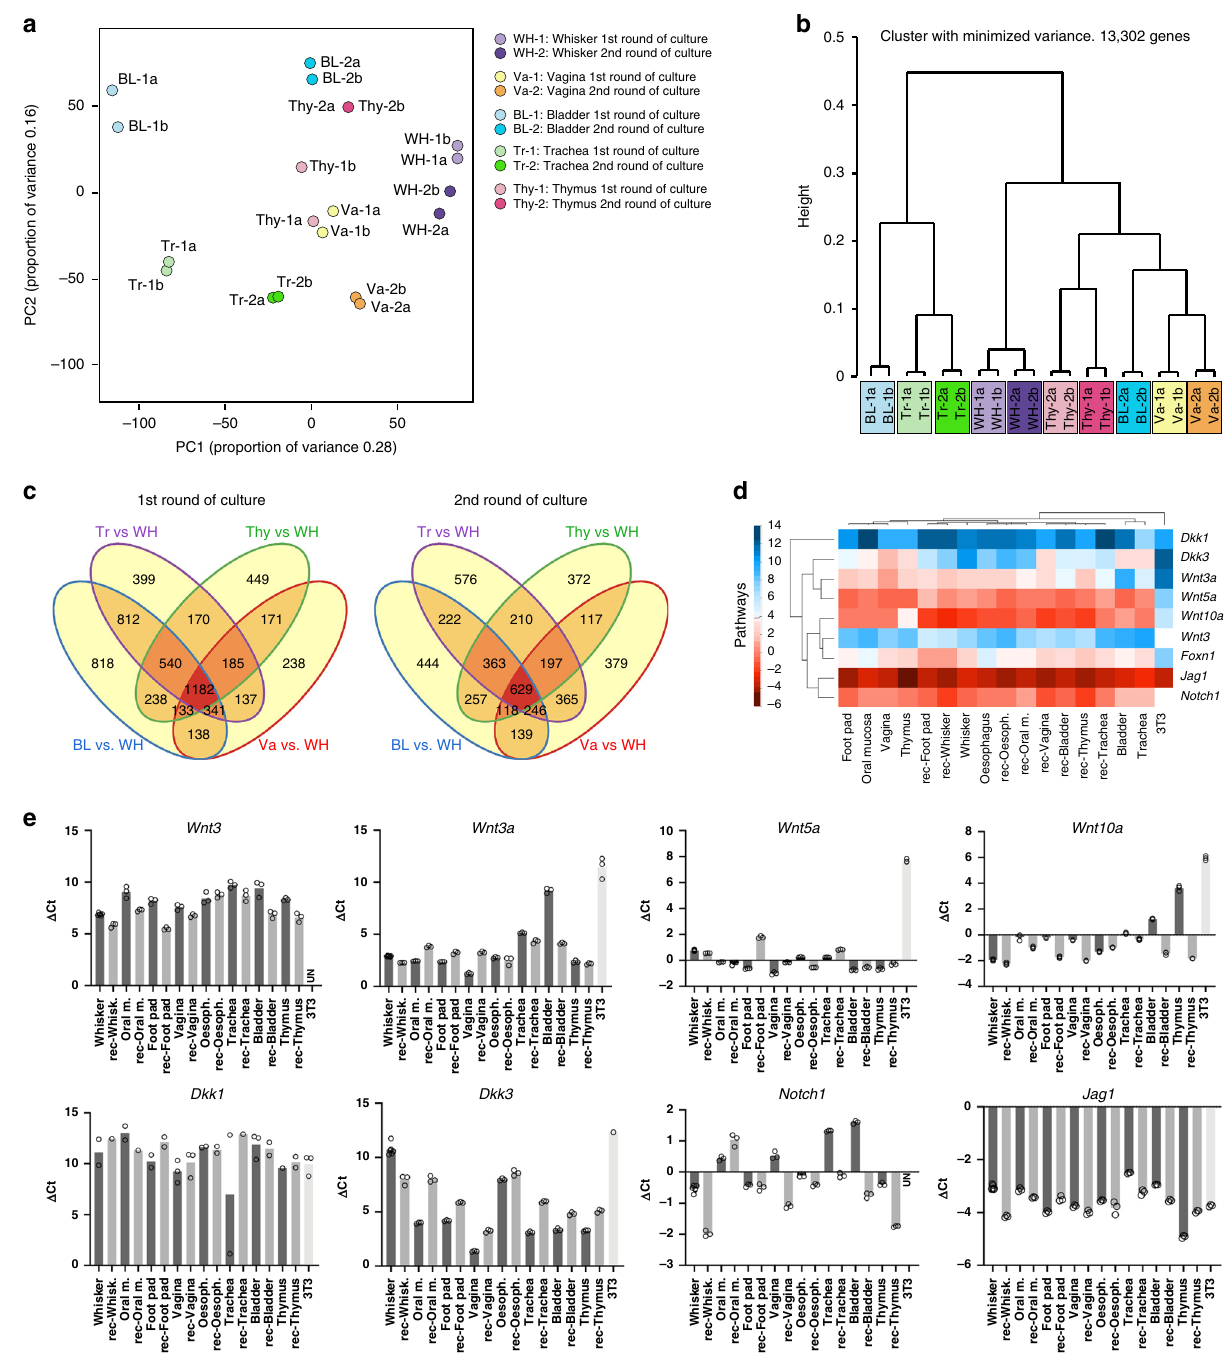
Fig. 3 Gene expression analysis of Tp63-expressing epithelial stem cells before and after skin transplantation. A RNA-Seq analysis was performed on epithelial stem cells cultured from whisker hair follicle (WH), vagina (Va), thymus (Thy), bladder (dome) (BL), and trachea (Tr) before they were transplanted into a newborn mouse skin microenvironment (1st round) and after they were recovered from the transplants (2nd round recovered). Cells were FACS sorted on EGFP expression before total RNA was extracted. a Principal component analysis (PCA) of the full transcriptomes. b Expression clustering analysis. c Venn diagram showing the number of up- and downregulated genes, fold-change >2, adjusted p value < 0.05 for each tissue in comparison with hair follicle adjusted p value < 0.05. d Heat map for the expression of some representative genes of different pathways important for hair follicle development and signaling. e Dot plot showing the expression of several genes of the Wnt and Notch signaling pathways in epithelial cells cultured before and after transplantation (1st and 2nd rounds of culture), determined by qPCR analysis. Housekeeping genes were used as normalizer ( TBP , SDHA, and Tubb ). Mean of 3 – 9 technical replicates with individual data represented by empty circles. Rec: recovered cells, 2nd round of